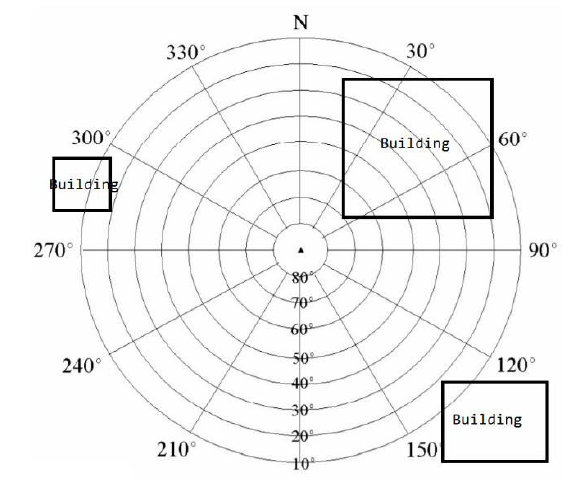
Figure 3. Visibility obstruction diagram of T002, showing minimal obstruction except on the northeast side.